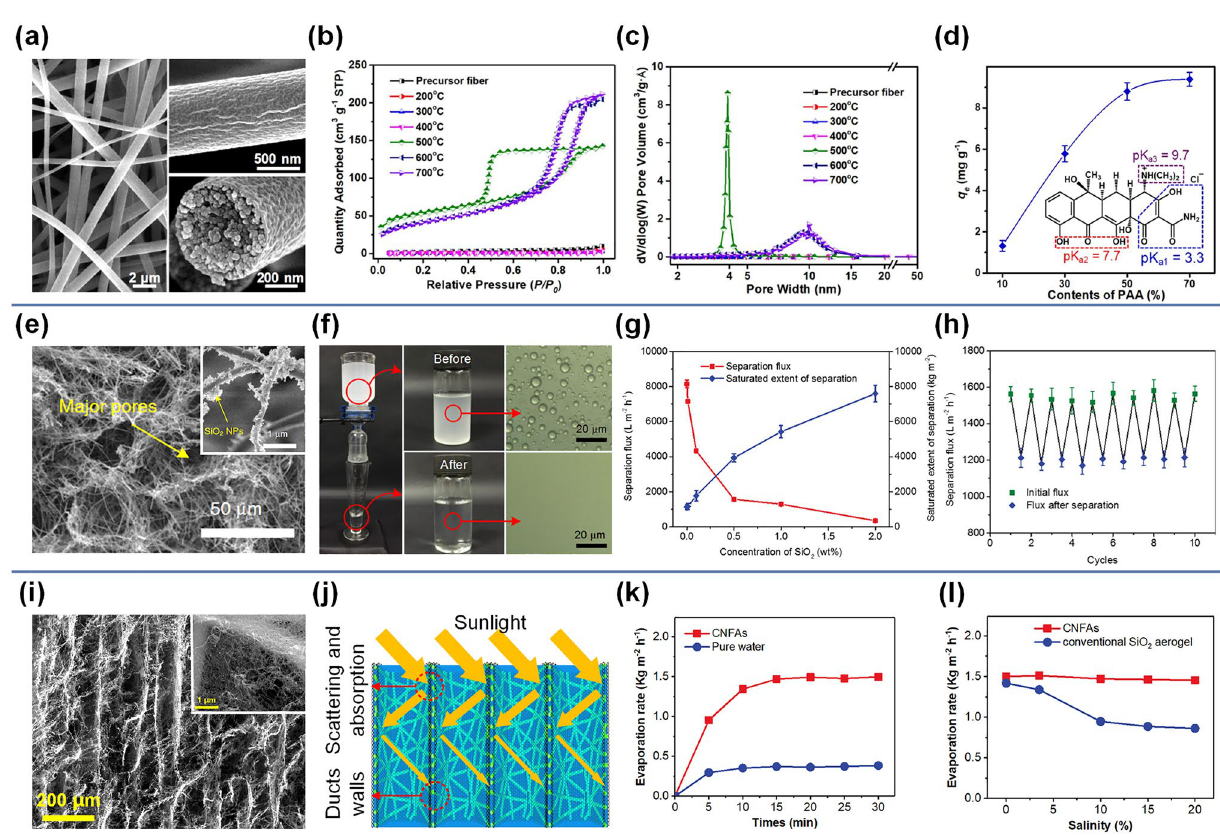
Fig. 11 a SEM images of mesoporous SNFs [194]. b Nitrogen adsorption–desorption isotherms of mesoporous SNFs at various calcination temperature [194]. c The corresponding pore size distribution curves [194]. d Adsorption performance of relevant mesoporous SNFs [194]. Cop‑ yright 2021, Elsevier. e SEM image showing open cell geometry of the aerogels. The inset is the corresponding magnified SEM image revealing SiO 2 nanoparticles anchored on the nanofibers [203]. f Separation device of water‑in‑oil emulsions and the microscopic photographs of emul‑ sions before and after separation [203]. g Separation flux and saturated extent of separation of nanofibrous aerogels [203]. h Changes of the flux and flux recovery over 10 cycles [203]. Copyright 2015, American Chemical Society. i SEM image showing cellular architecture of the aerogel. The inset is the magnified SEM image displaying the CNTs networks in nanofibrous framework [208]. j Schematic illustration of multiple scat‑ tering and absorption of light [208]. k Evaporation rate versus solar light irradiation time under 1‑sun irradiation [208]. l The evaporation rate of as‑prepared aerogels in different salinity of brine under 1‑sun irradiation [208]. Copyright 2020,